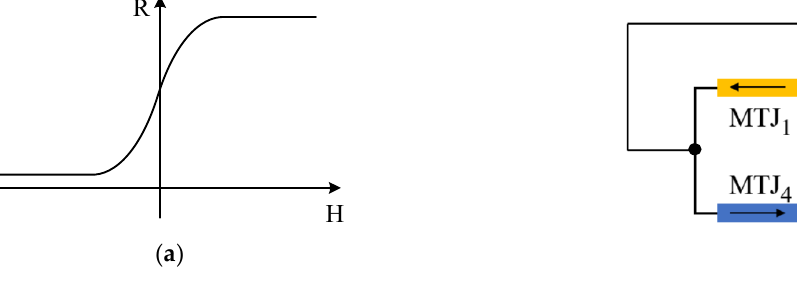
Figure 3. TMR sensing characteristics. ( a ) Resistance of magnetoresistance versus magnetic field, ( b ) Wheatstone bridge structure of the TMR sensor.